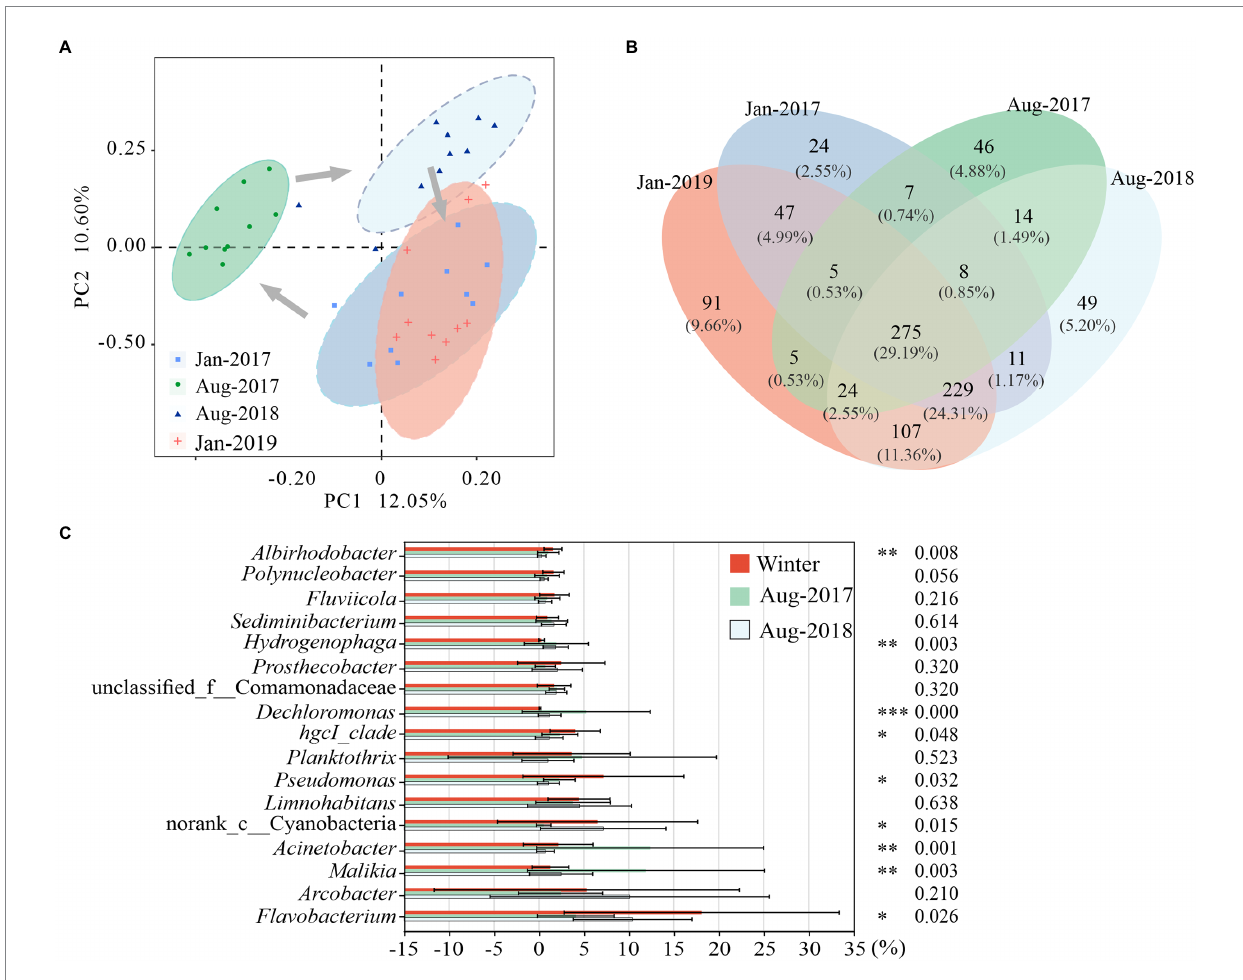
FIGURE 3 Differences of microbial communities in karst rivers among four sampling times (Jan-2017, Aug-2017, Aug-2018 and Jan-2019). (A) Principal co- ordinates analysis (PCoA) of microbial community structure based on Bray-Curtis distance at genus level. (B) Venn diagram of microbial community at genus level. (C) Significantly Different of genus among two winter, Aug-2017 and Aug-2018. Kruskal-Wallis test with p -values were * p < 0.05, ** p < 0.01, *** p <